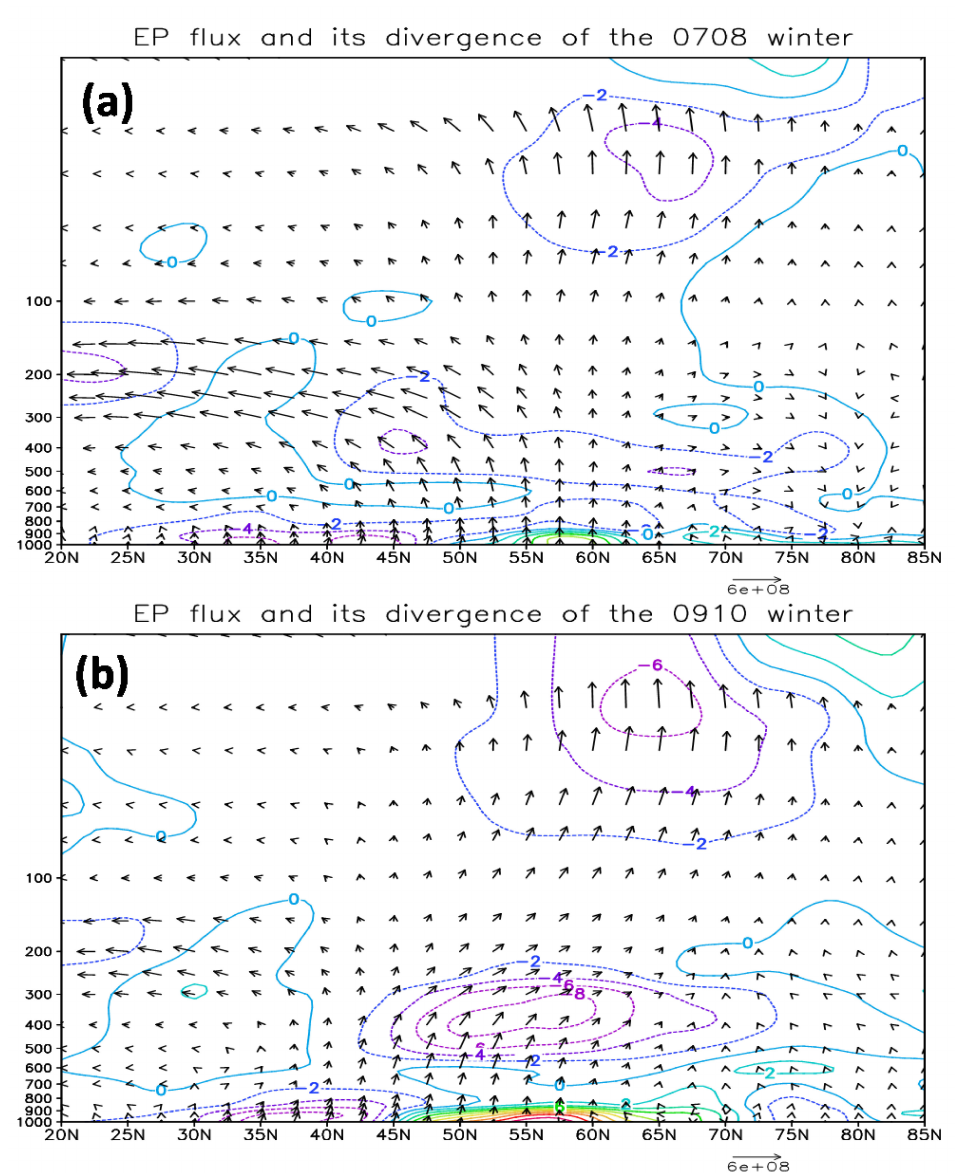
Figure 13. ( a ) The EP flux (kg/s 2 ) and its divergence (m · s − 1 · d − 1 ) in the winter of 2007/08. ( b )